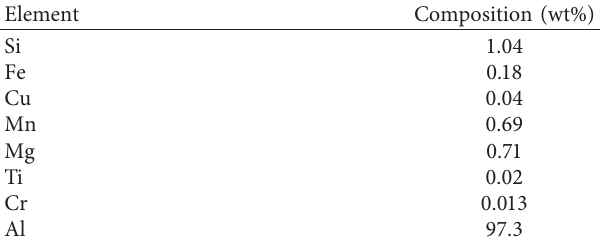
Table 1: Composition of 6351 Al alloy